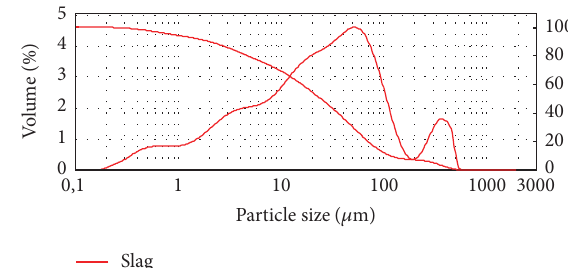
Figure 3: Particle size distribution of slag.